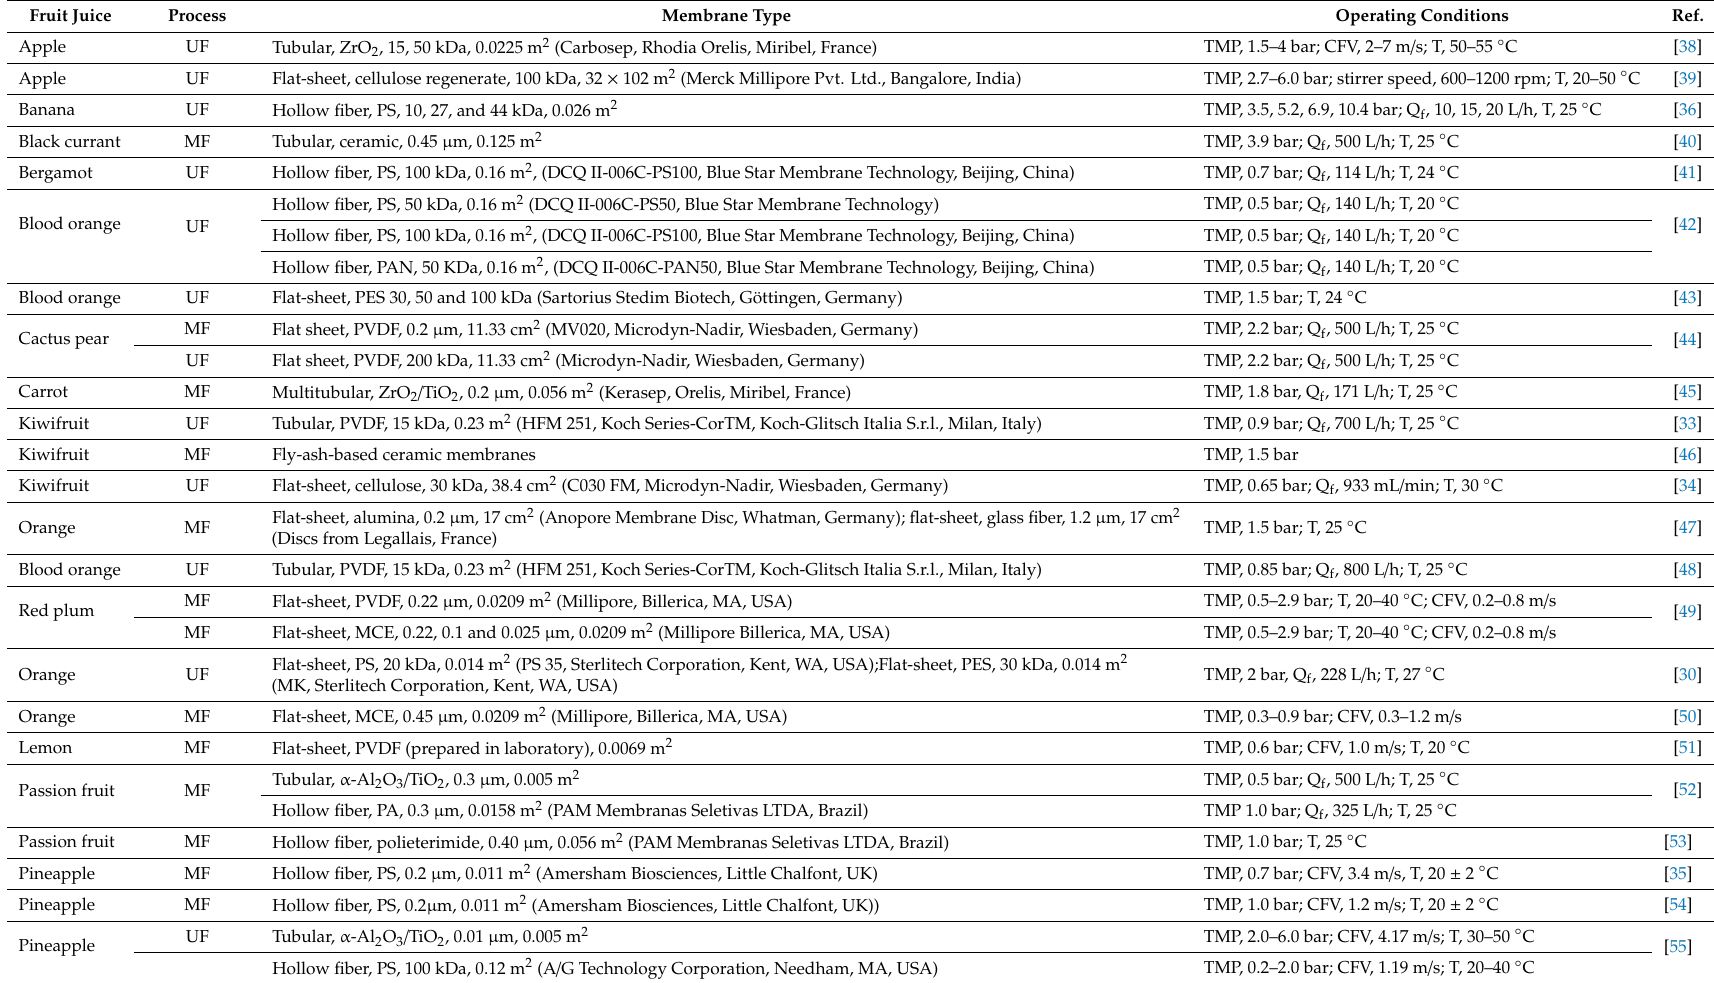
Table 2. Fruit juice clarification by MF and UF